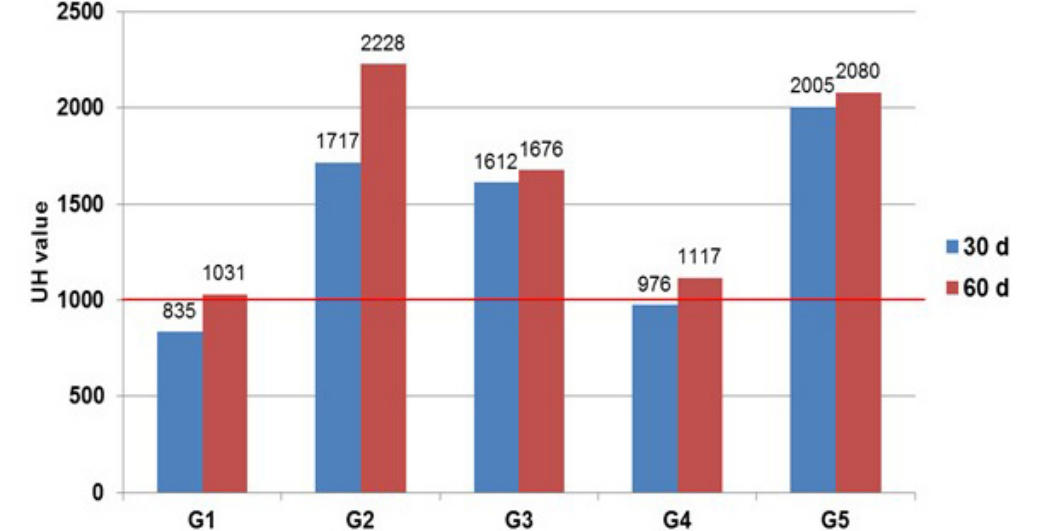
Figure 7. Mean Hounsfield unit (HU) value at the defect site of all groups 30 and 60 days after surgical procedure. Observation by CT scan. Red line indicates minimum value expected for regular cortical